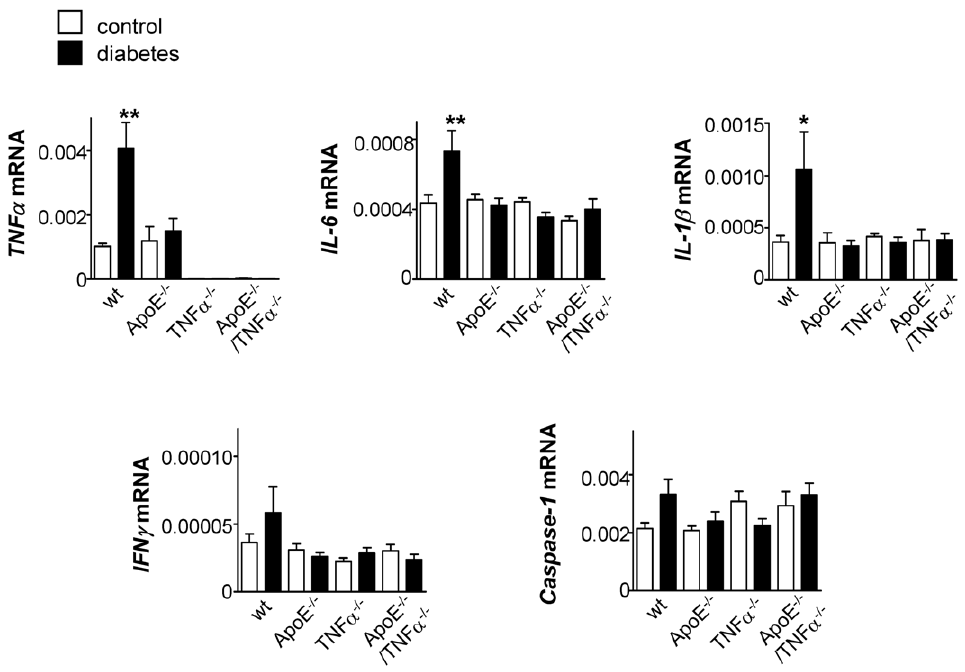
Figure 4. Diabetes enhances the expression of inflammatory cytokines in the retina of wt mice but not of ApoE- or TNF a deficient mice. Expression of TNF a , IL-6 , IL-1 b , IFN c and caspase-1 mRNA was measured by real time RT-PCR in intact retinas of control (white bars) and diabetic (black bars) wt, ApoE 2 / 2 , TNF a 2 / 2 and ApoE 2 / 2 /TNF a 2 / 2 mice. Values are normalized to the expression of cyclophilin B. * p , 0.05 and ** p , 0.01 indicates differences to control wt